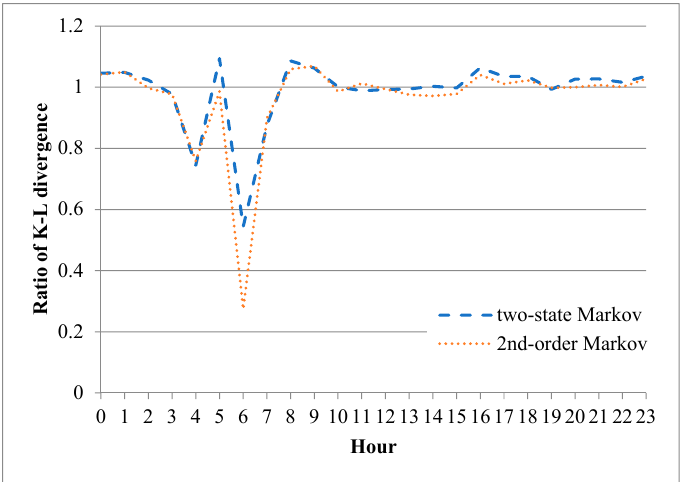
Figure 17. K-L divergence ratios of Markov error models for correct-frame bursts in each hour of the experimental period.